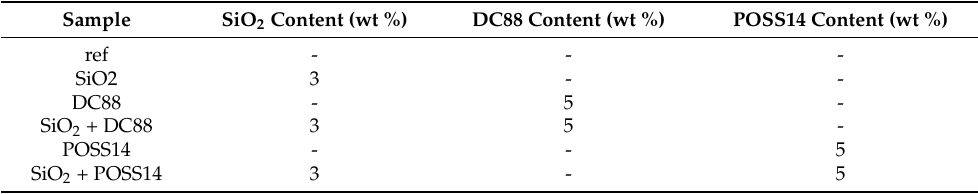
Table 1. List of manufactured polyurethane (PUR) nanocomposite